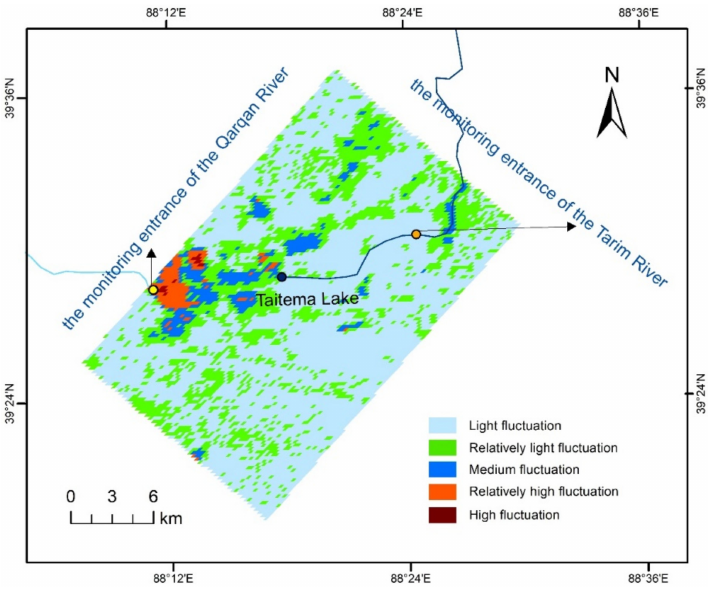
Figure 6. Variation coefficient of the fractional vegetation cover in Taitema lake region. Table 3. Statistics of variation coefficient of fractional vegetation coverage in Taitema lake